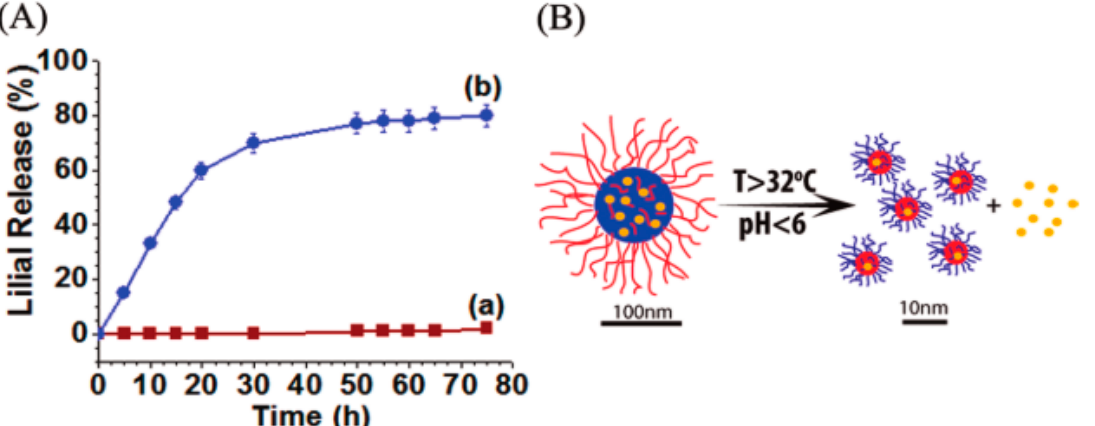
Figure 10. ( A ) Lilial release profile at simulated storage stage (a) and endosomal/lysosomal uptake stage (b): (a) 25 °C, pH = 7.4; (b) 37 °C, pH = 4.5. ( B ) Schematic representation of the dual responsive behavior of self-assembled PNIPAm-chitosan (CS)-Lilial nanocarriers. The PNIPAm and CS are represented in red and blue, respectively. Lilial is represented in yellow. Reprinted with permission from [127].